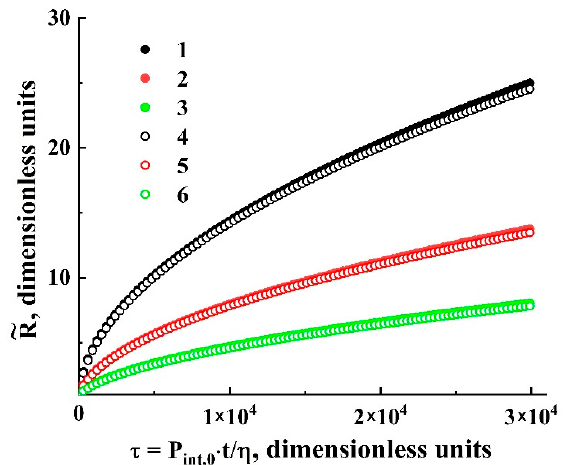
Figure 6. Theoretical dependencies of (cid:101) R on the dimensionless time lapse τ . 1,4— Ξ = 0.01; 2,5— Ξ = 0.003; 3,6— Ξ = 0.001. The datasets (1–3) correspond to T = 310 K and P int,0 = 8.3 MPa; the datasets (4–6) correspond to T = 333 K and P int,0 = 10.0 MPa.